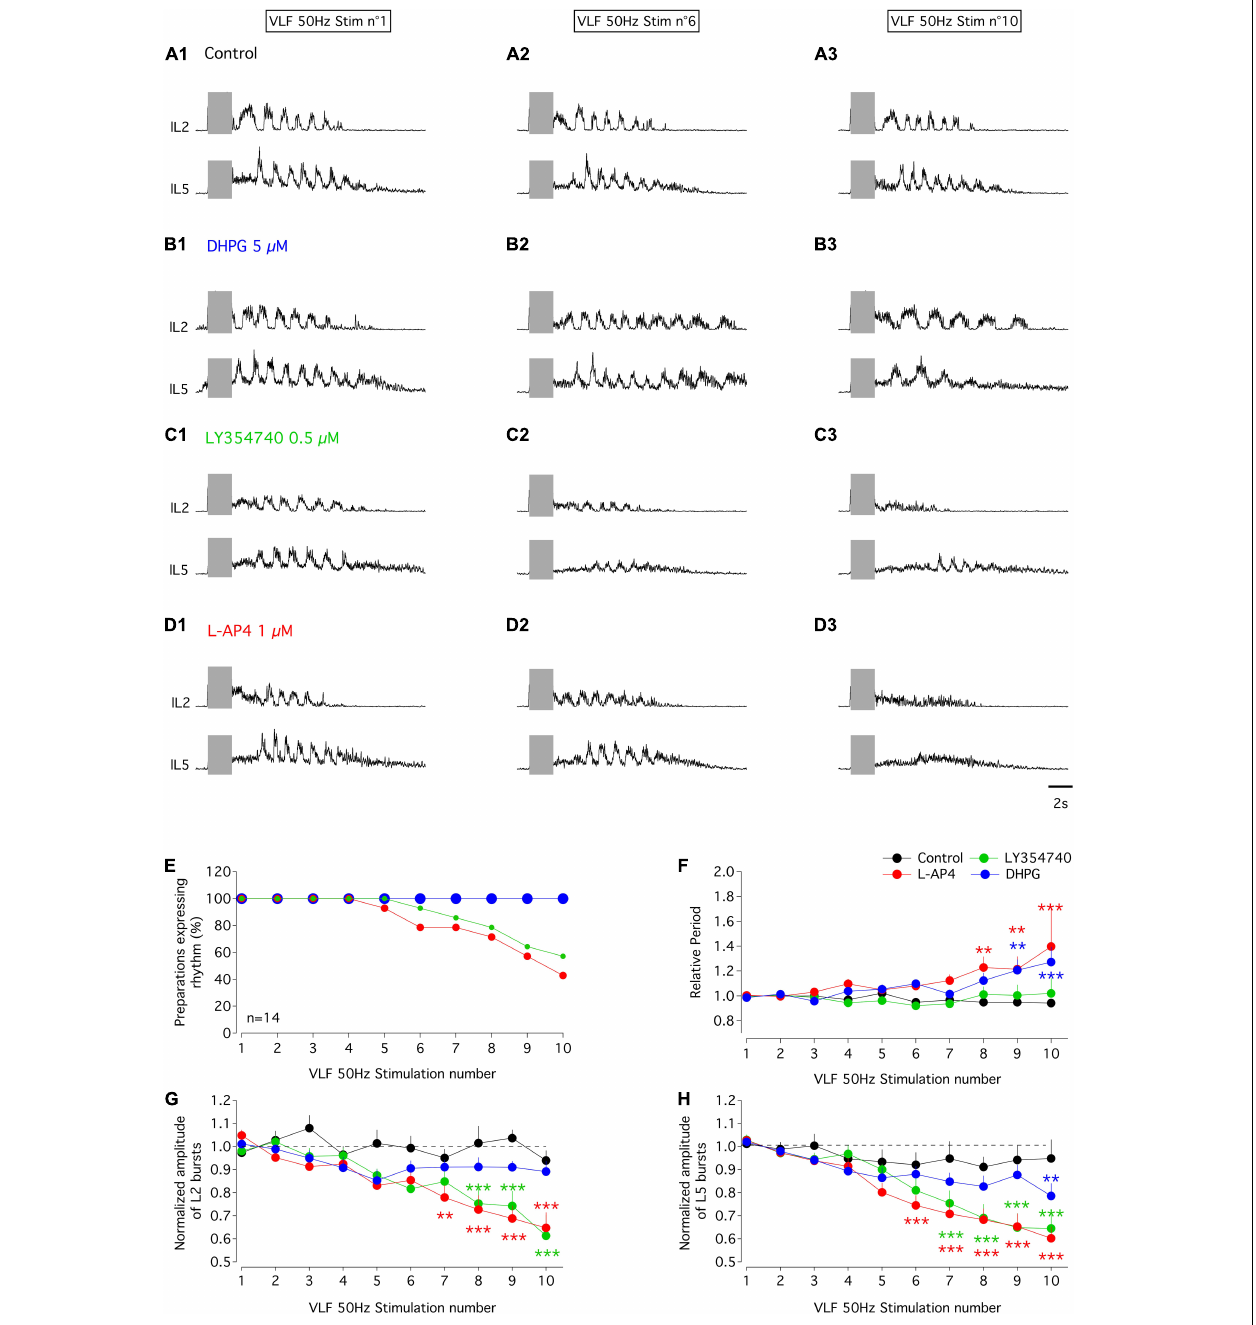
FIGURE 7 | Effects of mGluR agonists on VLF-induced fictive locomotion in the isolated spinal cord in vitro of P1-P3 mice. (A–D) Representative sample traces of bouts of fictive locomotion induced by the first (left panels), sixth (middle panel) and tenth (right panels) stimulation (gray rectangles) of series of 10 successive stimuli applied to VLF axons (50 Hz, 2 s) every 2 min in a whole spinal cord preparation from a P1 mouse in control condition in aCSF (A) or during successive exposure to DHPG (B) , LY354740 (C) or L-AP4 (D) . Each drug application started at the beginning of the stimulation series and was separated by at least an one hour washout period with aCSF. (E) Percentages of isolated spinal cord preparations ( n = 14) expressing locomotor episodes during series of 10 VLF stimulations in control condition and during application of mGluR agonist. Note that the curve obtained in the presence of DHPG is superimposed on that obtained in aCSF. (F) Evolution of cycle period of VLF-induced-fictive locomotion rhythm normalized to the mean period computed for the two first stimulations in each series in control condition and during the application of each mGluR agonist. (G) Same data representation as in (F) for the amplitude of L2 locomotor-related bursts normalized to the mean amplitude value obtained in response to the two first stimulations in the series. (H) Same data representation as in (F) for the amplitude of L5 locomotor bursts normalized to the mean amplitude value obtained in response to the two first stimulations in the series. Differences between the two first stimulations and the following ones in the series were evaluated using two-way RM ANOVA followed by Sidak’s post hoc tests. ** p < 0.01 and *** p < 0.001 significantly different.